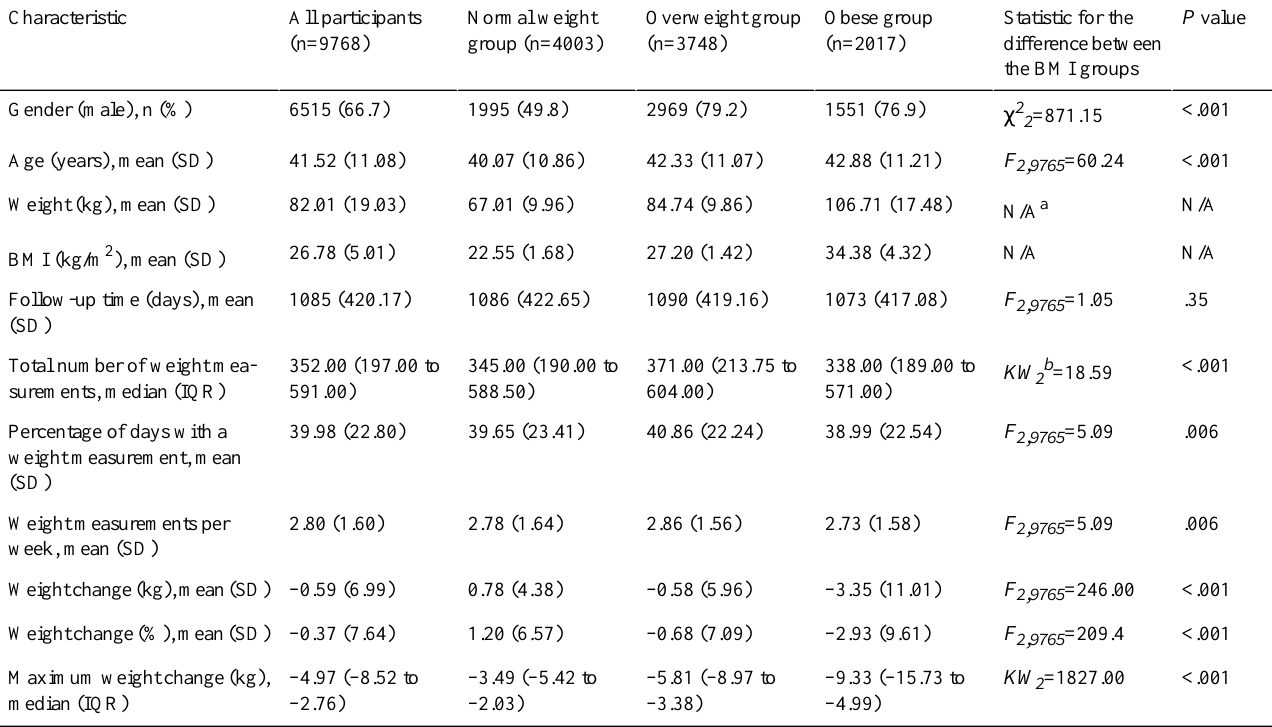
Table 1. Background characteristics and self-weighing–related information for smart scale users.